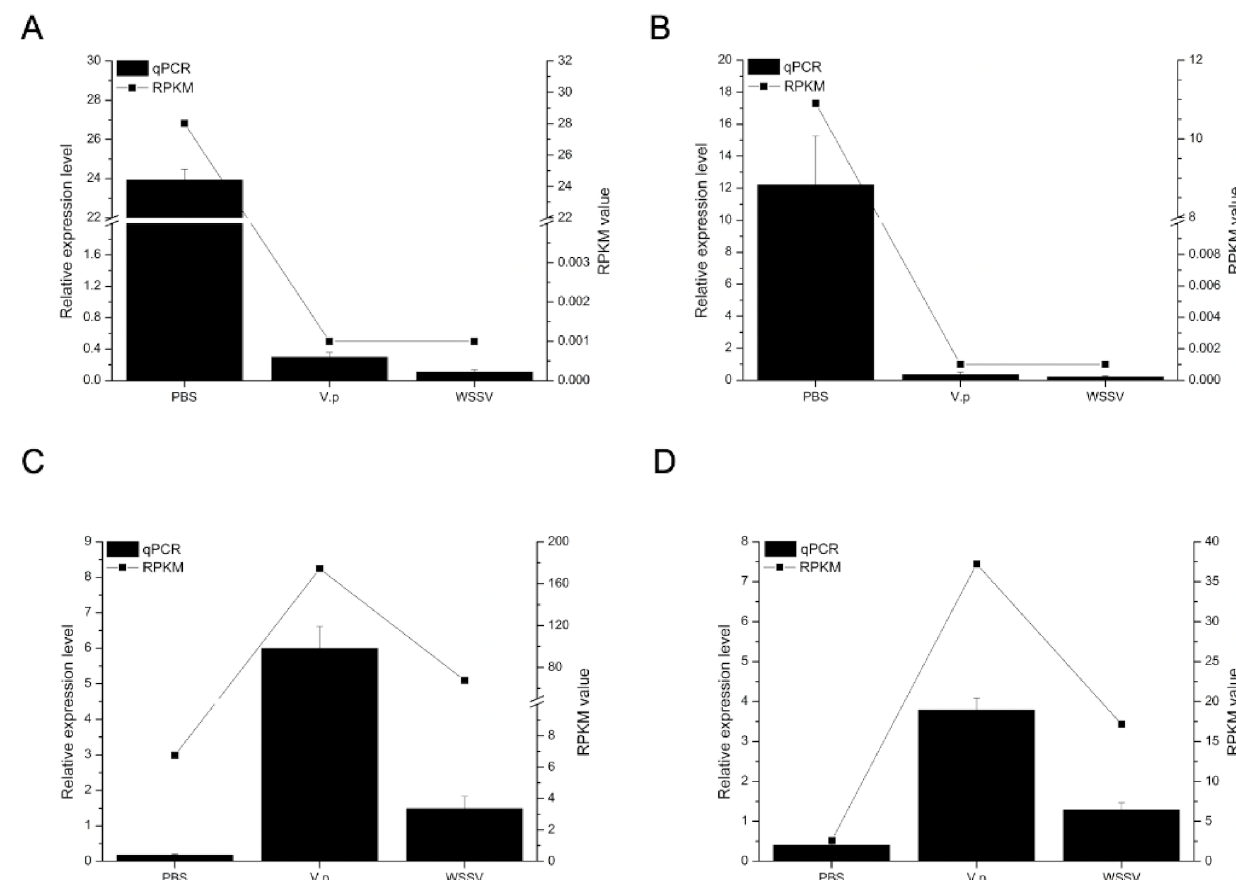
Figure 2. Expression profiles of four unigenes. ( A ) Unigene0055376 (alpha 2 macroglobulin); ( B ) Unigene0018885 (solute carrier organic anion transporter family member 5A1-like); ( C ) Unigene0024101 (neuroparsin 1); ( D ) Unigene0028929 (C-type lectin). The X axis represents the different treatments. Columns and bars represent the means and standard error of relative expression levels from the qPCR results (Y axis at left). Lines represent the RPKM value from the transcriptome results (Y axis at right).